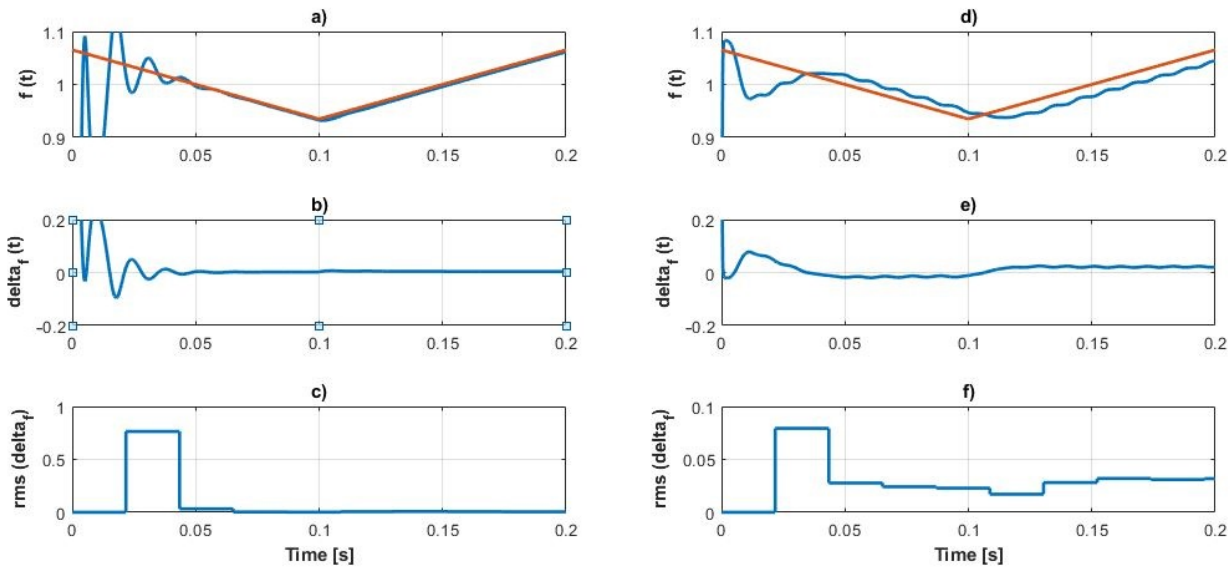
Figure 9. Frequency swing for ± 3 Hz deviation and slew rate 60 Hz/s. DDSRF-FLL ( a – c ) and DSOGI-FLL ( d – f ), where: ( a , d ) frequency estimated value (orange—reference, blue—tested algorithm), ( b , e ) frequency error between compared algorithms, and ( c , f ) RMS value-form frequency error.